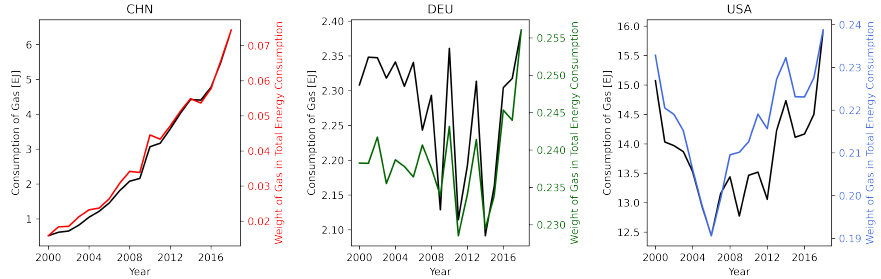
Figure 19. The evolution of natural gas consumption and its share in the total energy mix.